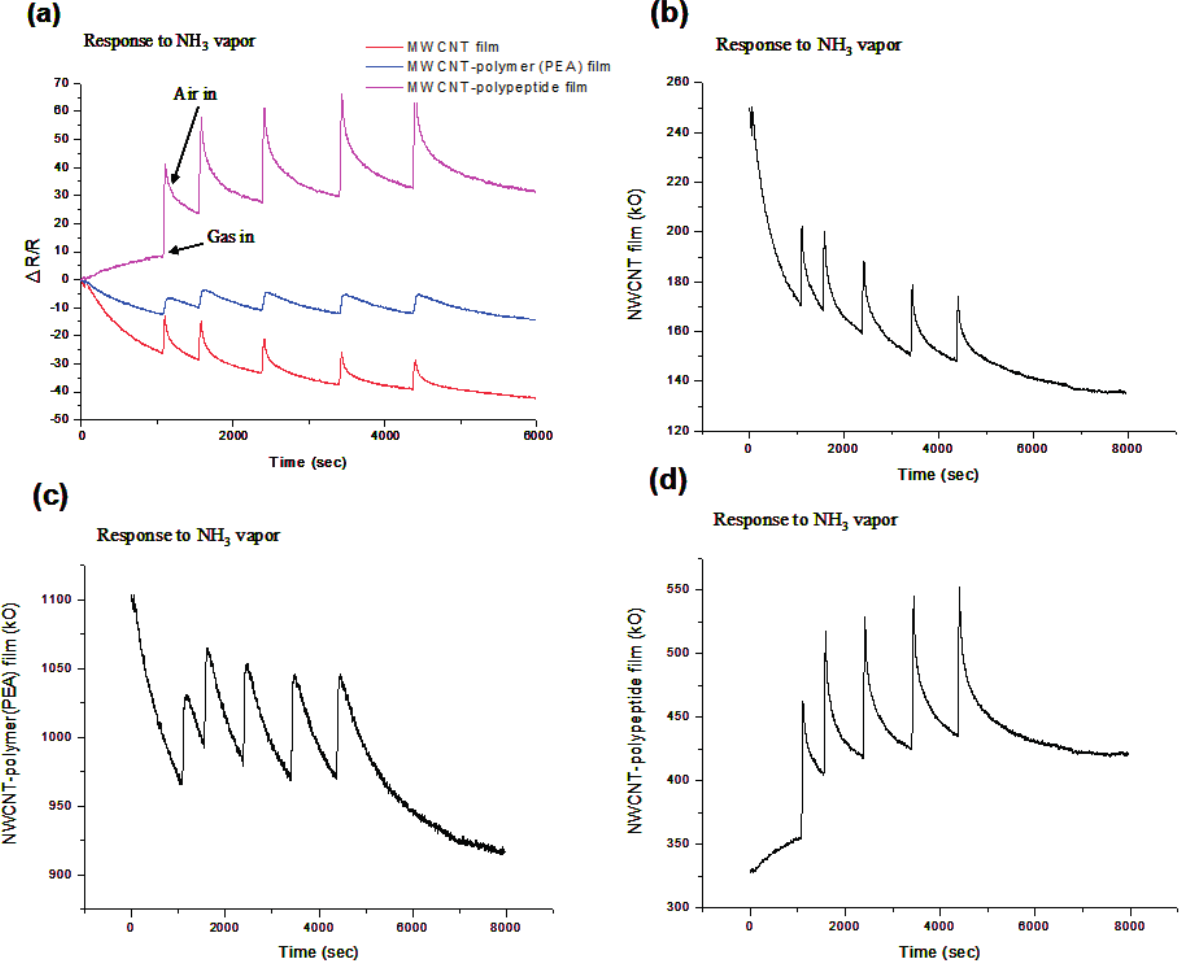
Figure 3. Gas sensing responses to NH 3 gas (283 ppmv) of ( a ) MWCNT films, MWCNT-poly(ethyl acrylate) (PEA) composite films, and MWCNT-polypeptide composite films; ( b ) MWCNT films; ( c ) MWCNT-PEA composite films; and ( d ) MWCNT-polypeptide composite